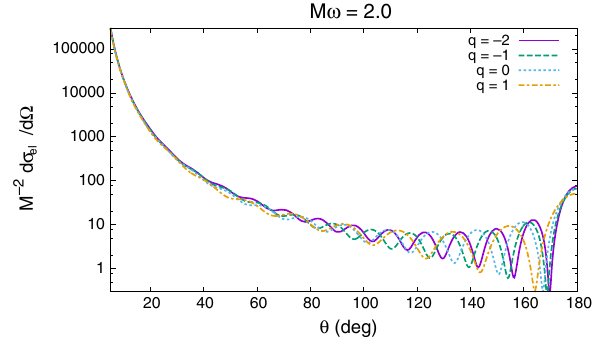
Fig. 7 Scalar differential scattering cross sections of black holes with q = − 2 , − 1 , 0 , 1. The cases q = 0 , 1 correspond respectively to the Schwarzschild and the extreme Reissner–Nordström black holes